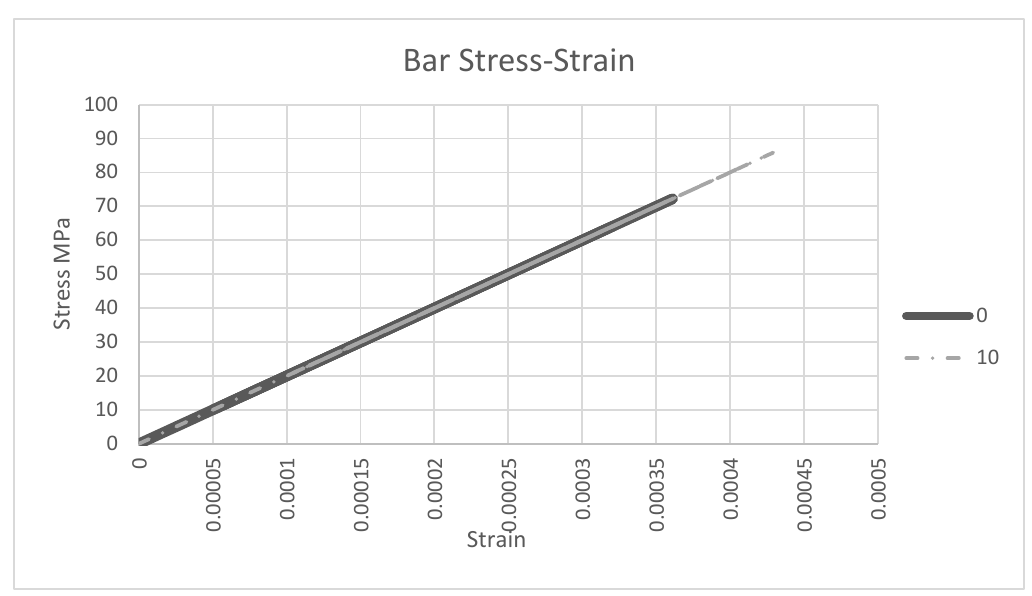
Fig. 20. The maximum stress-strain curve in the joint node